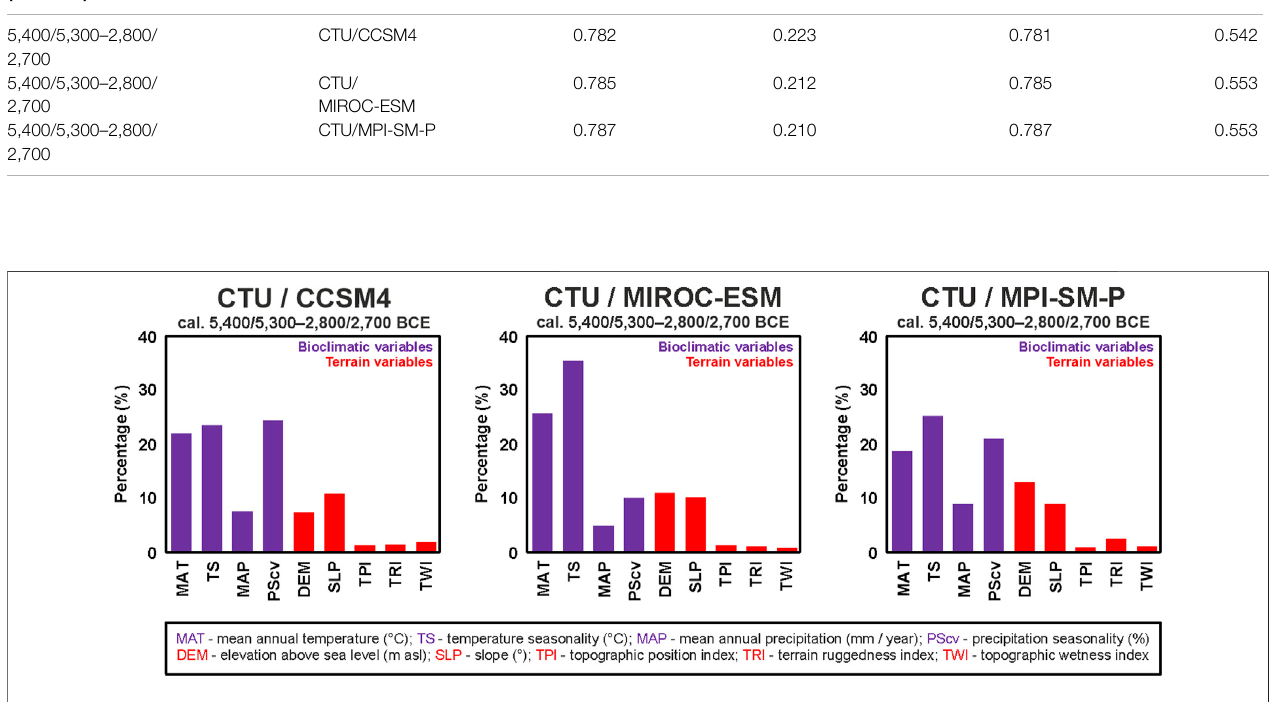
Frontiers in Earth Science |